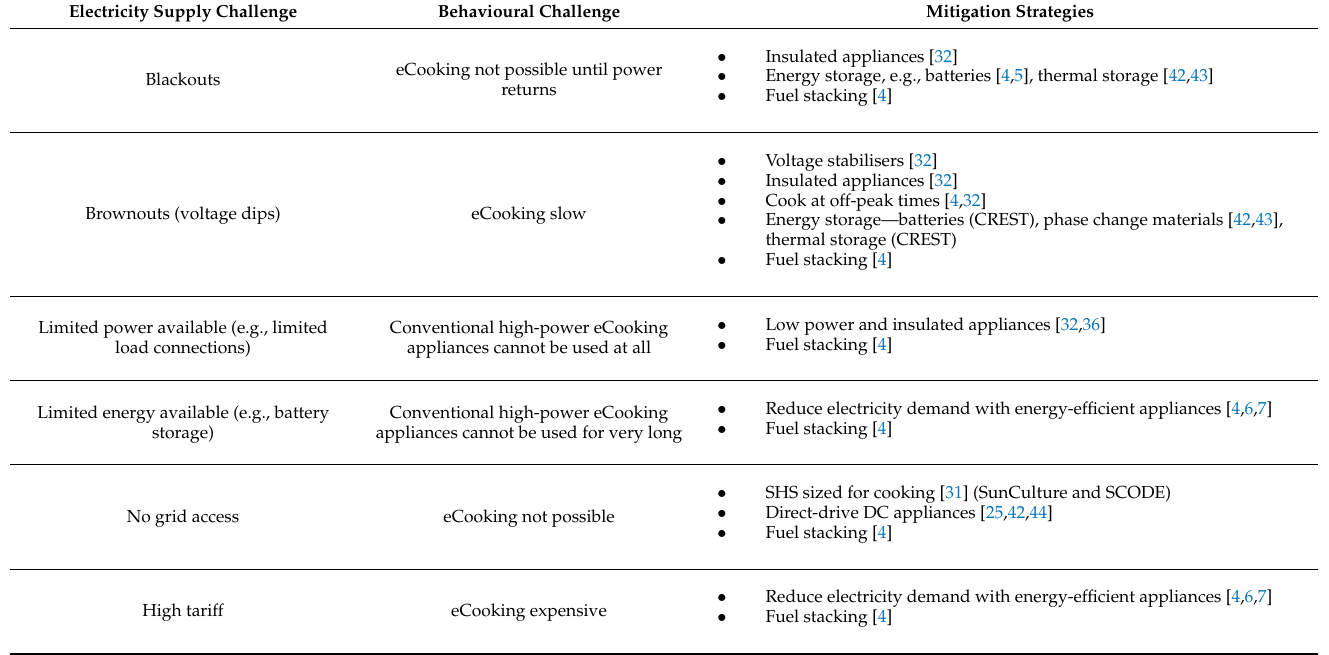
Table 2. Mitigation strategies for behavioural challenges resulting from common electricity supply